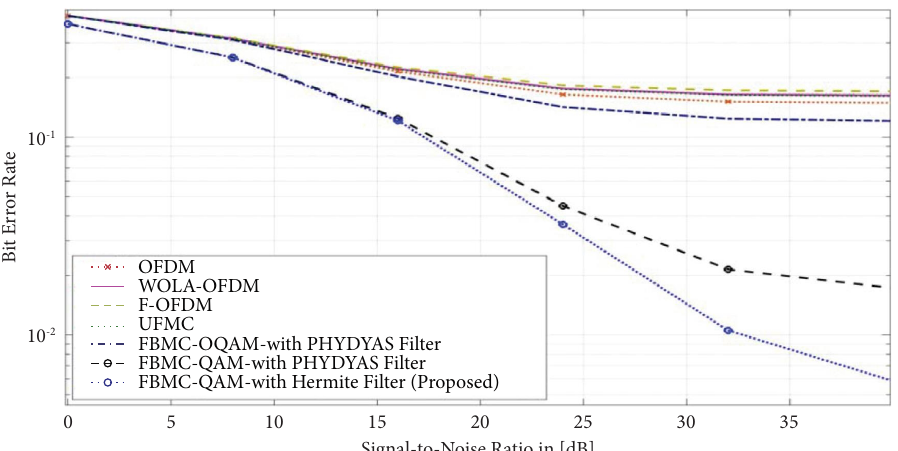
Figure 13: Bit error rate performance of diferent multicarrier modulation techniques for Vehicular B channel model at 256 QAM.